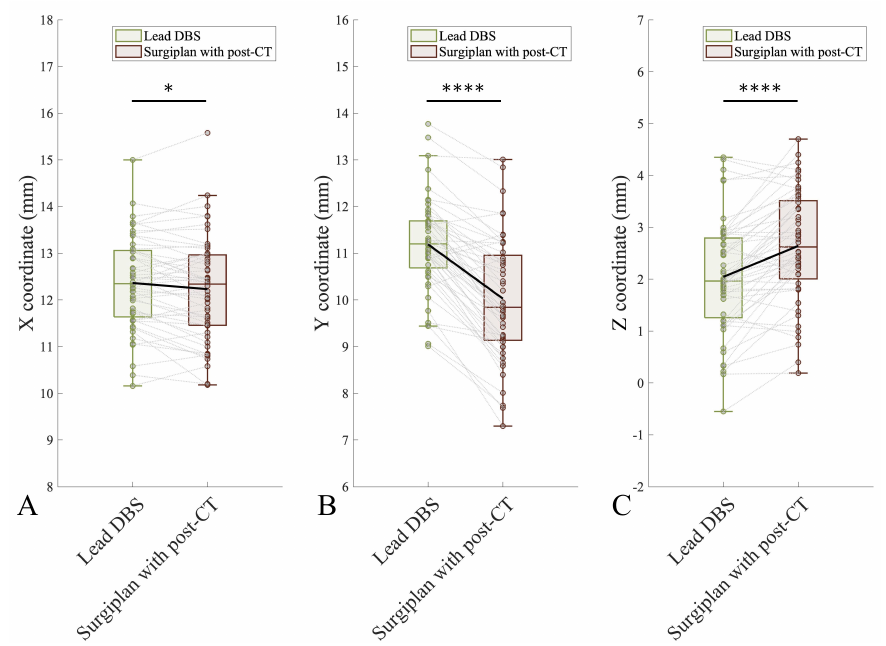
Figure 2. Comparison of electrode contact coordinates between Lead-DBS and Surgiplan with postoperative CT. A significant difference was found in the X ( A ), Y ( B ), and Z ( C ) coordinates between Lead-DBS and Surgiplan (X coordinate, p = 0.0251; Y coordinate, p < 0.0001; Z coordinate, p < 0.0001; all paired t -test). *: p < 0.05, ****: p <